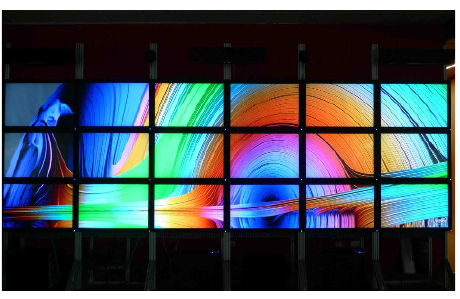
Figure 22. The KAUST REVE 18-panel display using CGLX-based CineBlaster3D video software. Julia4D Animation: Dan Sandin. Photo: Tom DeFanti. (Autostereo not turned off.)